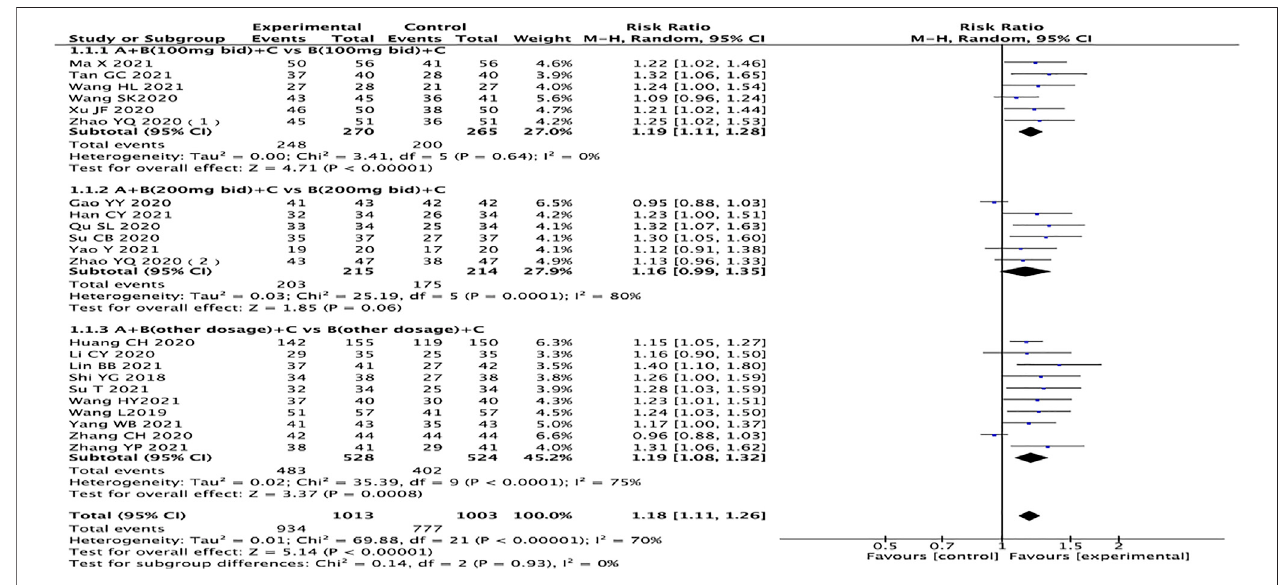
FIGURE 3 | Forest plot of the clinical ef fi cacy rates.